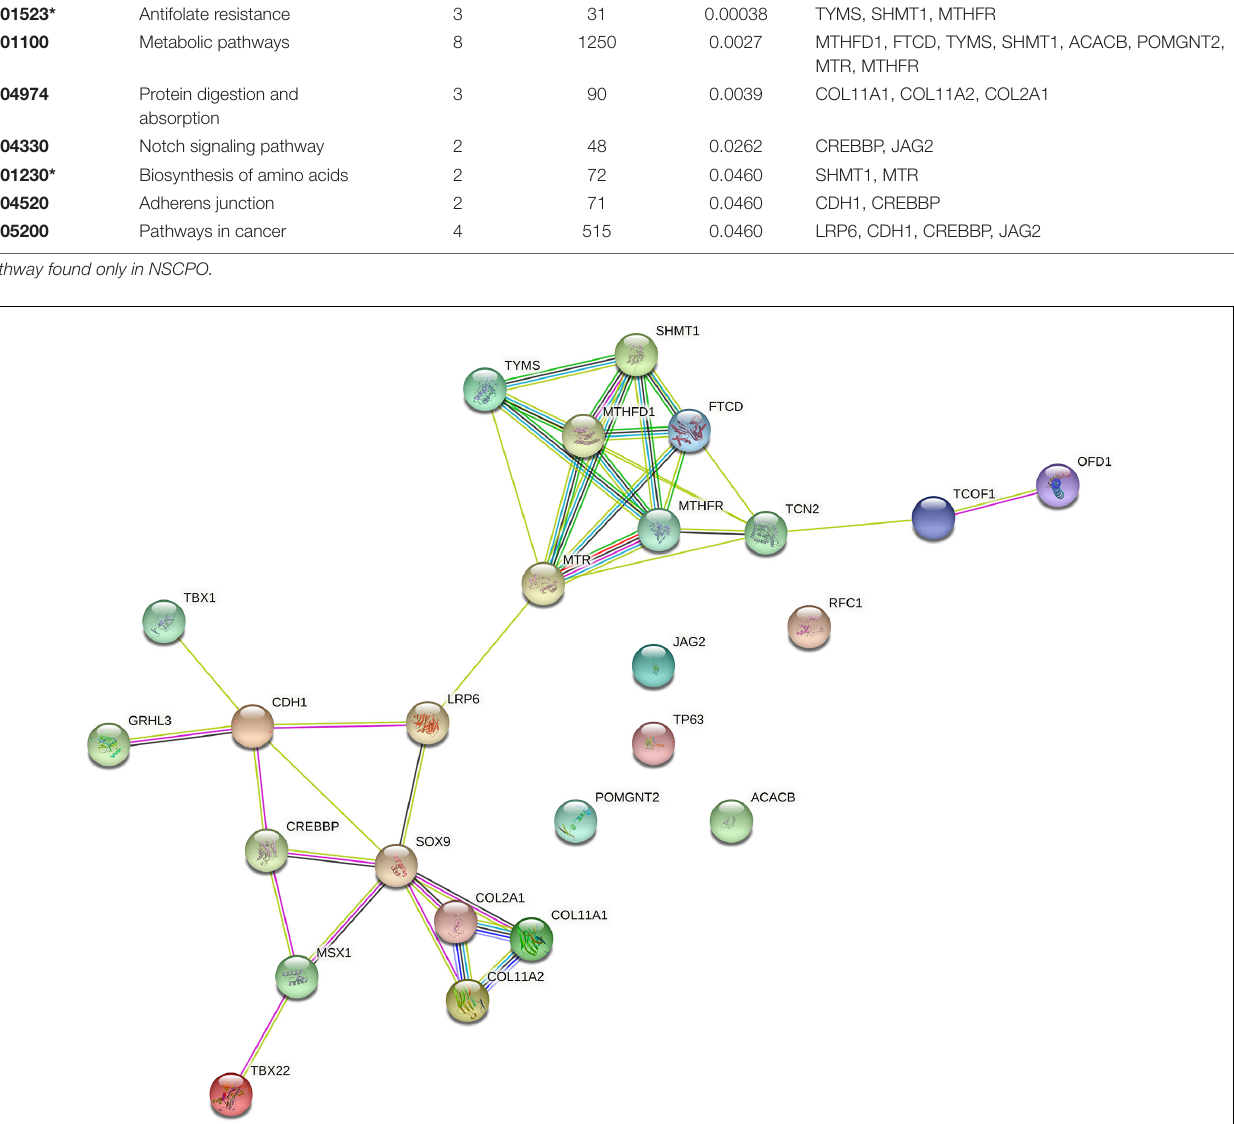
Observed Background False Matching proteins gene count gene count discovery rate in your network